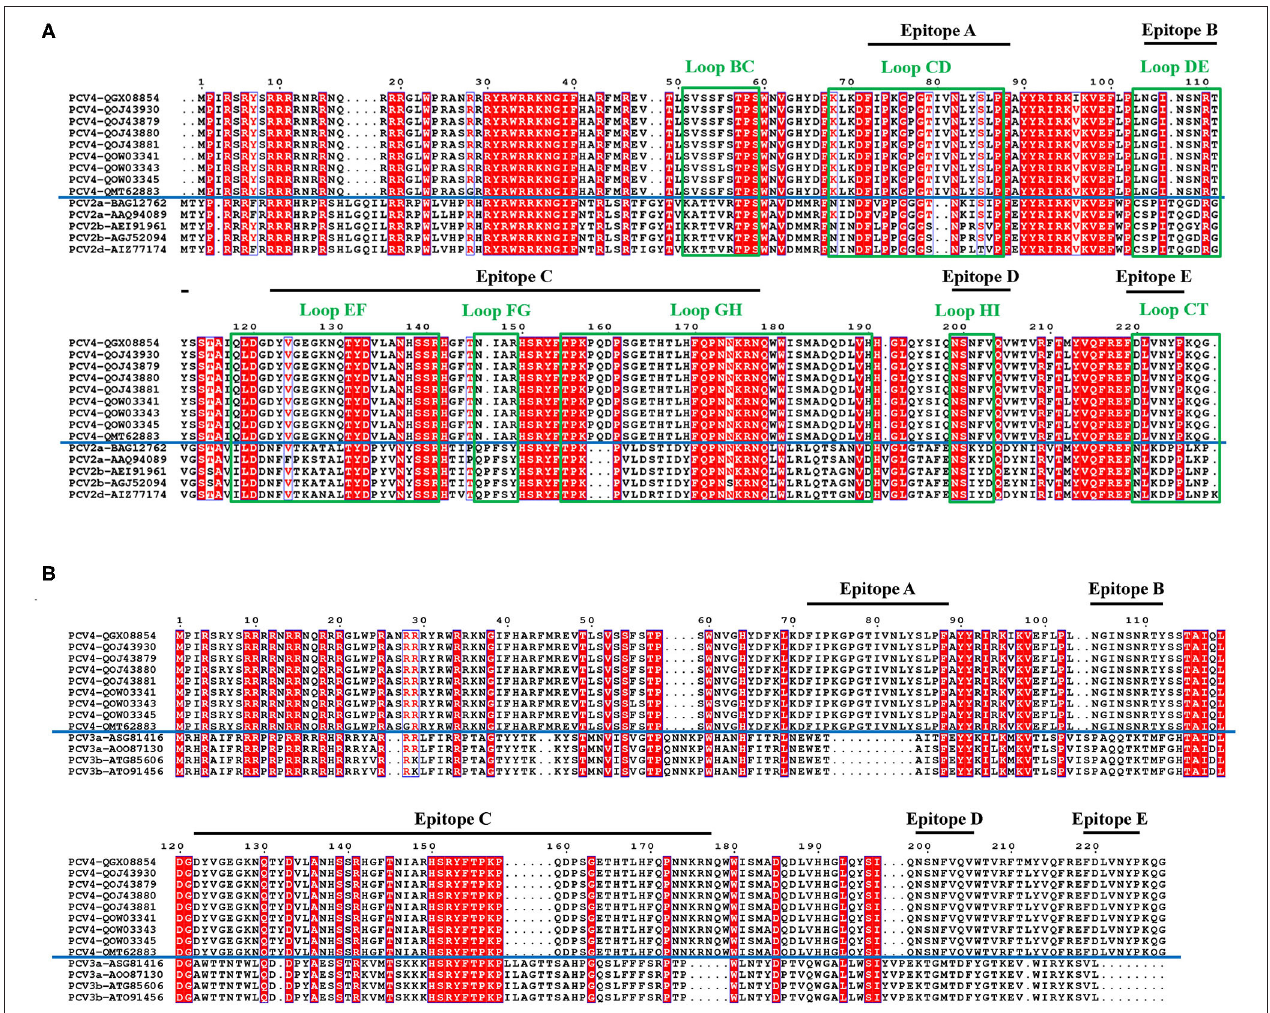
FIGURE 3 | Sequence alignment of PCV Caps. Comparative amino acid sequence alignments between PCV4 and PCV2 Cap (A) or PCV4 and PCV3 Cap (B) . All loops labeled with green rectangles and black lines represent predicted PCV4 potential linear B cell epitopes.